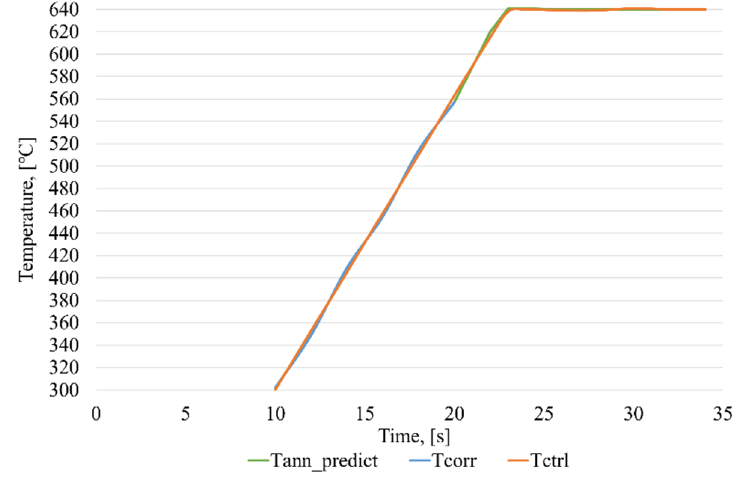
Figure 21. Graph of the intelligent control of the induction brazing process in the case of simulating the temperature measurements from one of the pyrometers, where Tcorr—temperature values obtained from a correcting pyrometer, Tctrl—temperature values obtained from a control pyrometer, Tann_predict—temperature readings from a pyrometer, modeled using ANN predict .